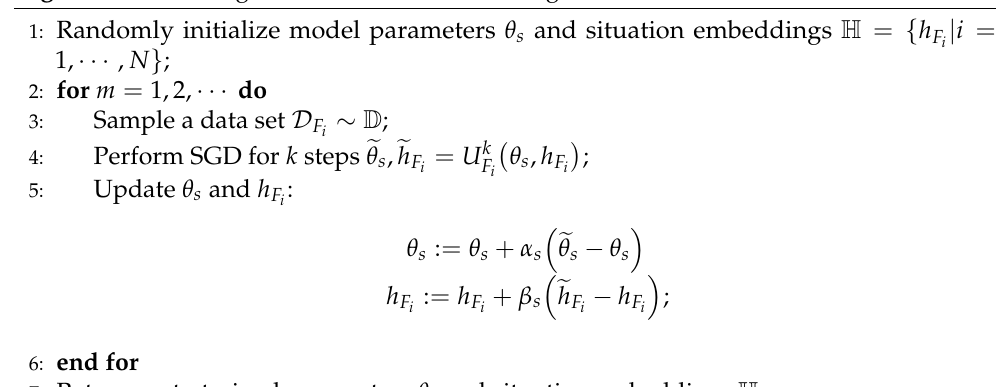
Algorithm 2 Training of the situation embedding model.